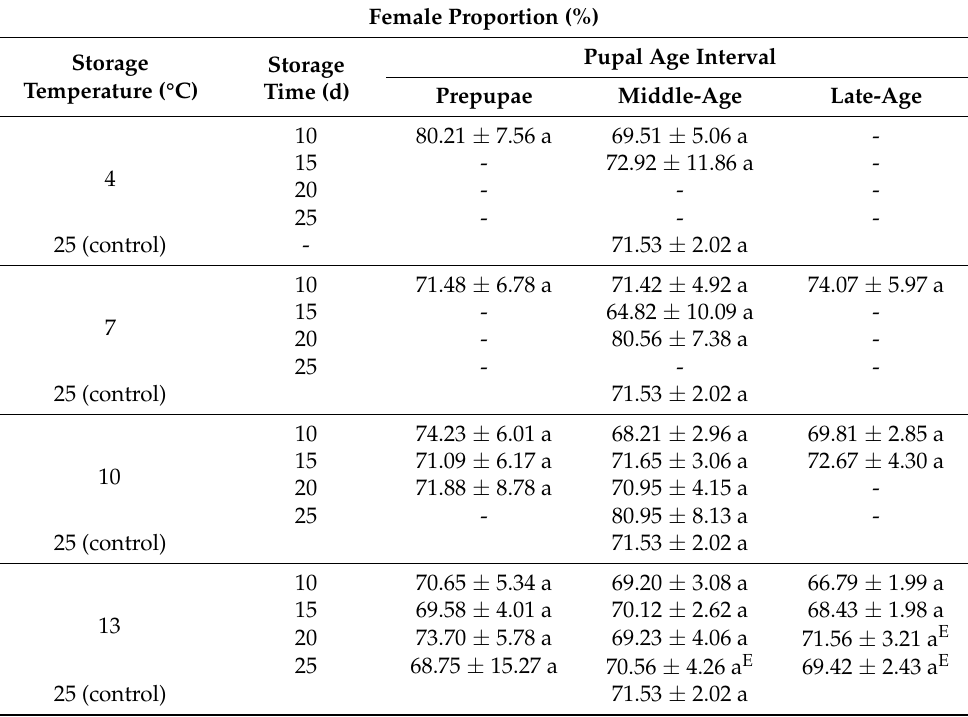
Table 2. Proportion of emerging P. incisi females after being subjected to different pupal cold storage treatments ( n =